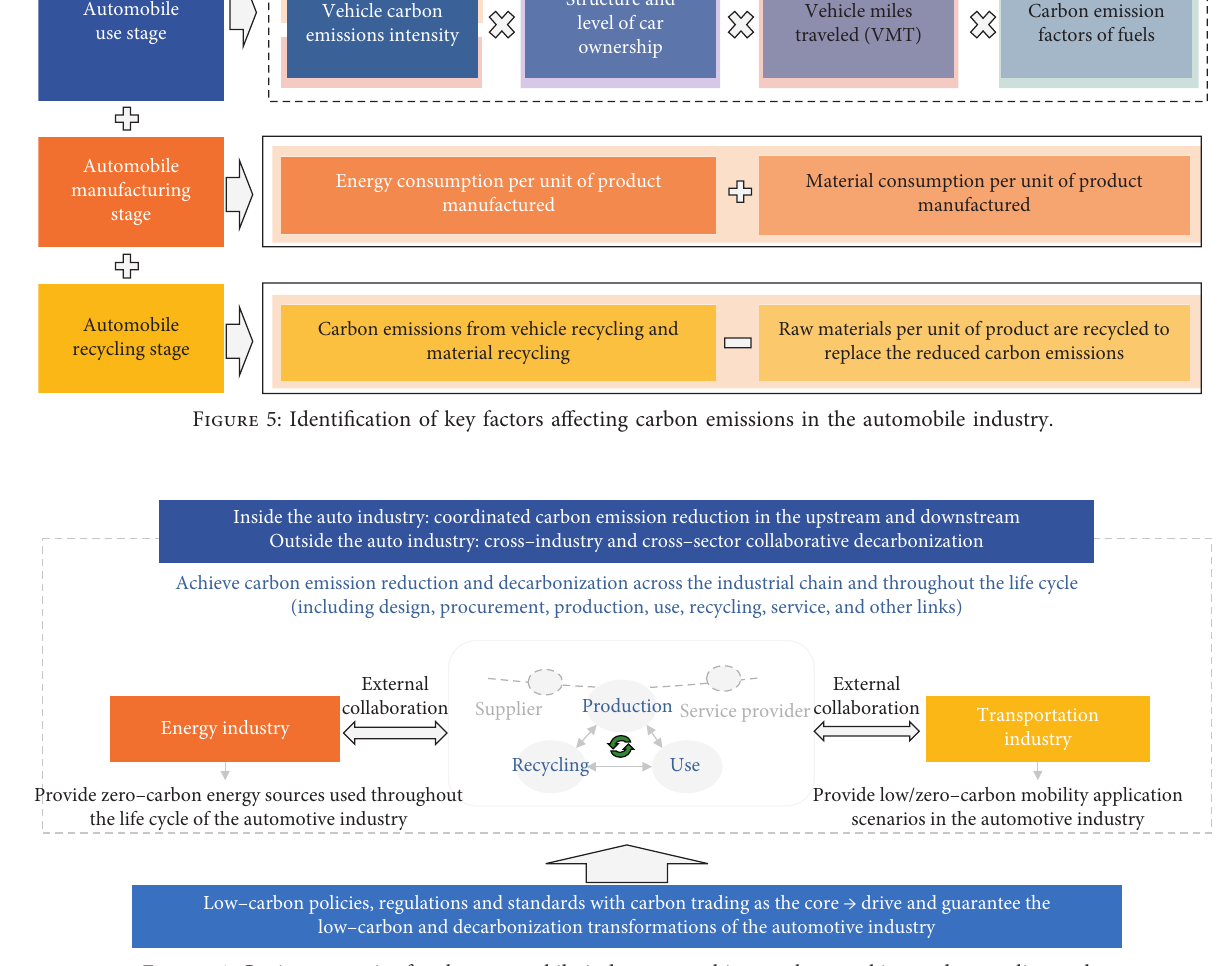
Figure 6: Coping strategies for the automobile industry to achieve carbon peaking and neutrality